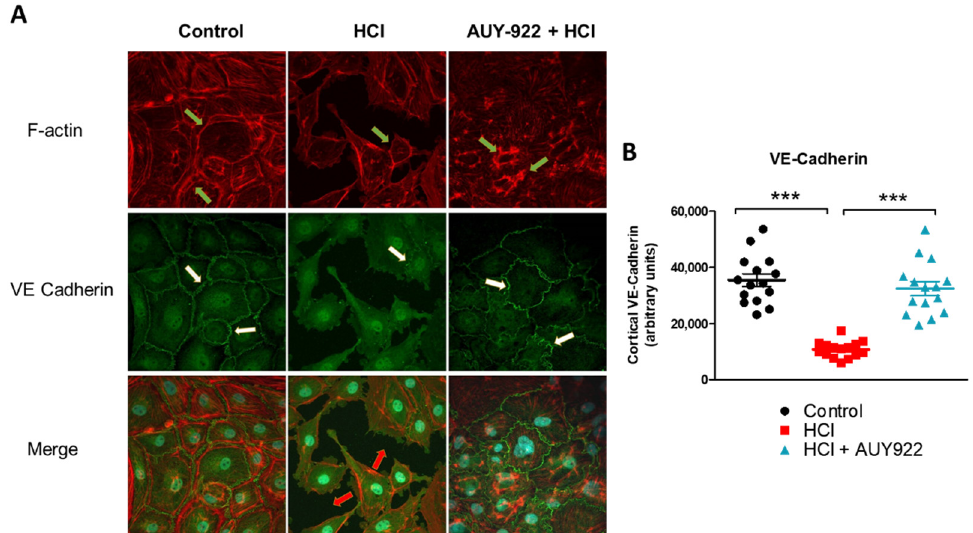
Figure 5. The HSP90 inhibitor, AUY-922, modulates HCl-induced cytoskeletal rearrangements and promotes the expression of adherent junction proteins in HLMVEC. ( A ) The activation of RhoA induced by HCl was completely inhibited after 24 h incubation of HLMVEC with AUY-922 (2 µM). ( B , C ) AUY-922 inhibited MLC2 activation and increased the expression of VE-cadherin. HLMVEC grown in 100 mm cultured dishes were pre-treated for 24 h with vehicle or 2 µM AUY-922 and then exposed to 0.01 N HCl. One hour later, cells were lysed, and samples were prepared for protein analysis by Western blotting. Means ± SEM; n = 3; **: p < 0.01; ***: p < 0.001 with one-way ANOVA and Tukey’s.